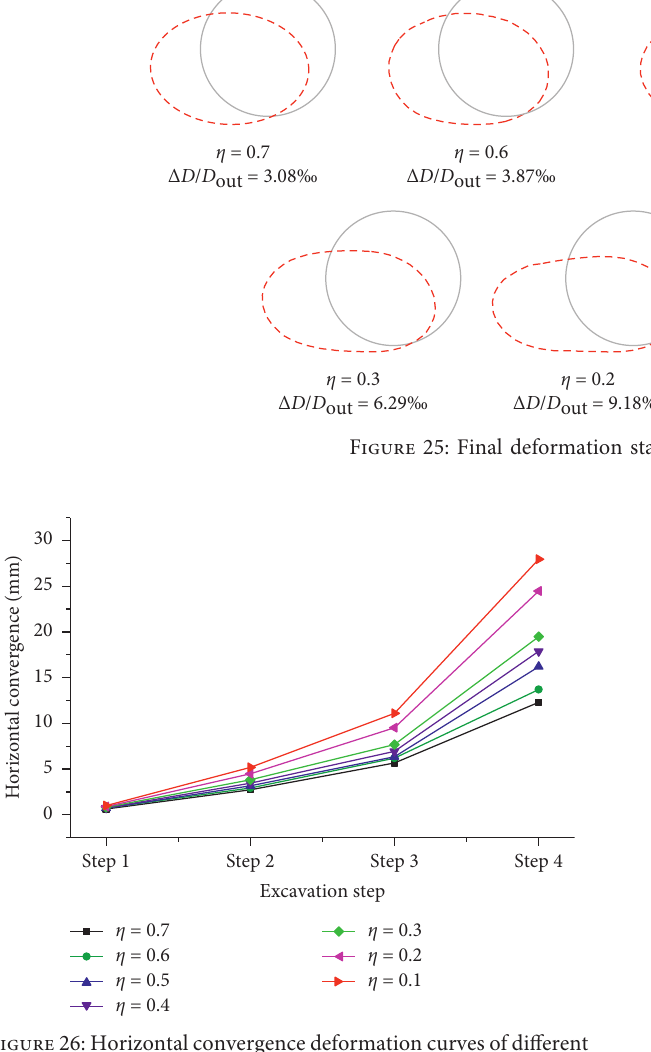
Figure 26: Horizontal convergence deformation curves of different values of η